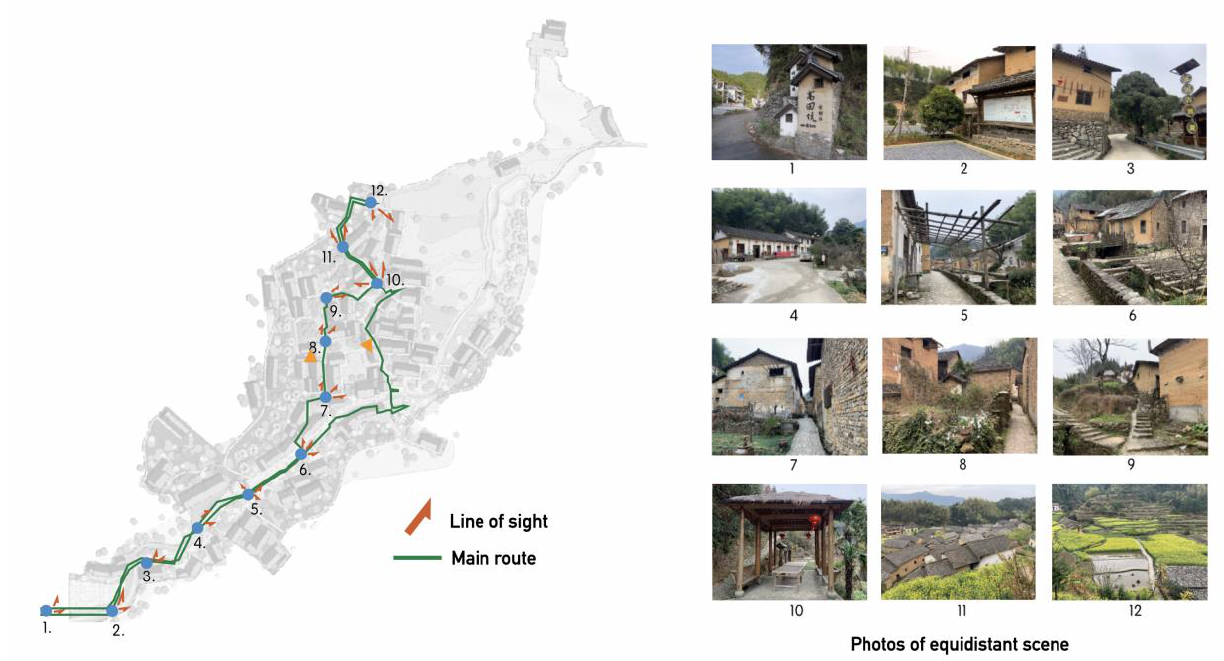
Figure 3. Main tour route, line of sight, and photos of equidistant scene.